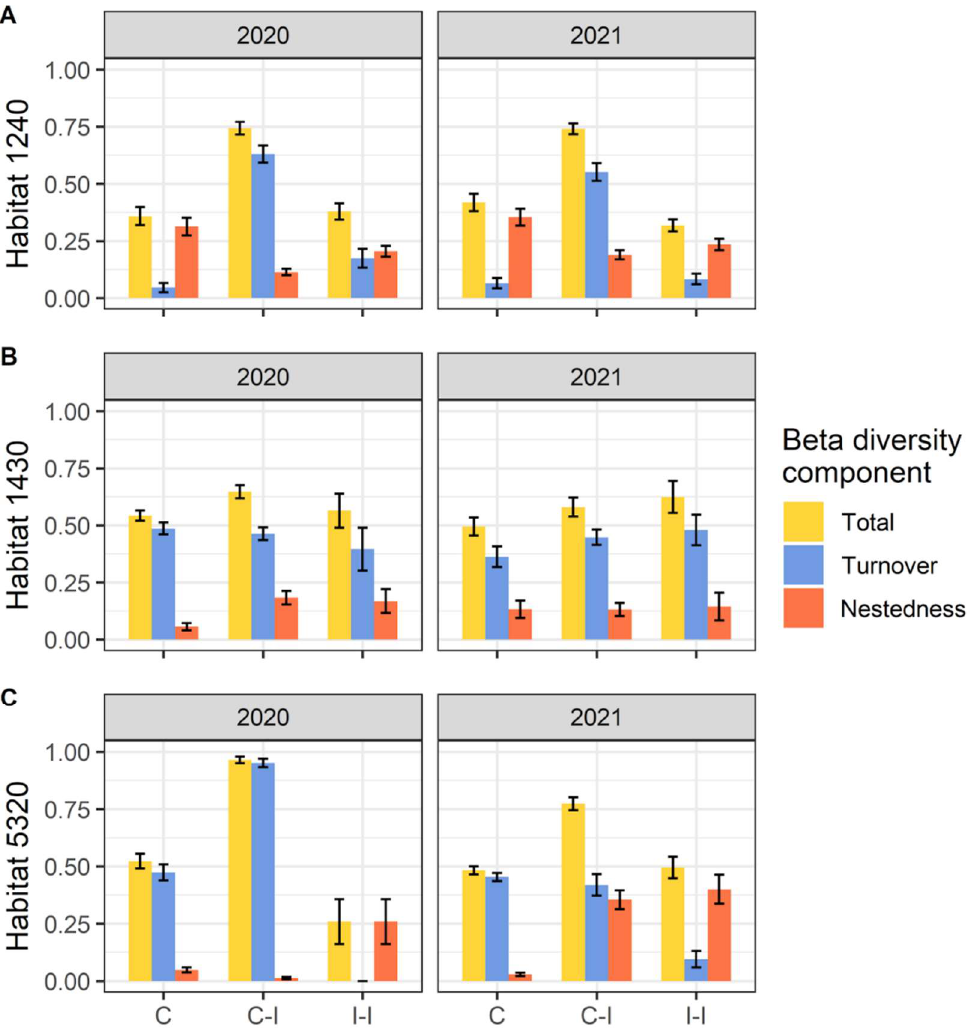
Figure 4. Total beta diversity and Turnover and Nestedness components in ( A ) habitat 1240 = vegetated sea cliffs of the Mediterranean coasts with endemic Limonium spp., ( B ) habitat 1430 = Halo-nitrophilous scrubs ( Pegano - Salsoletea ) and ( C ) habitat 5320 = Low formations of Euphorbia close to cliffs. Beta diversity components are separated per pairwise comparison (C = Control plots, I = Invaded plots) and year. Error bars correspond to standard error.